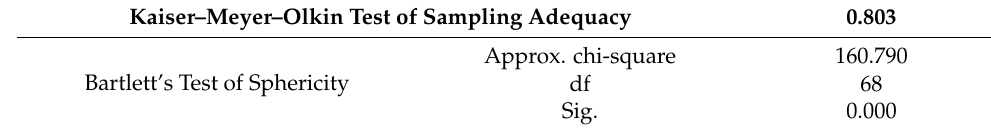
Table 4. KMO and Bartlett’s Test.